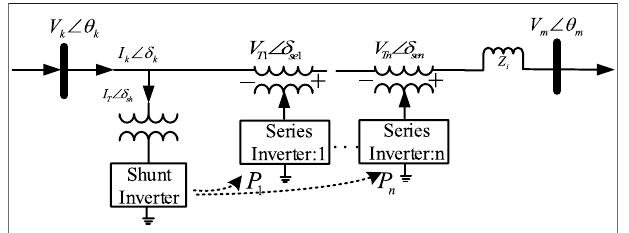
FIGURE 4 | PIM of the